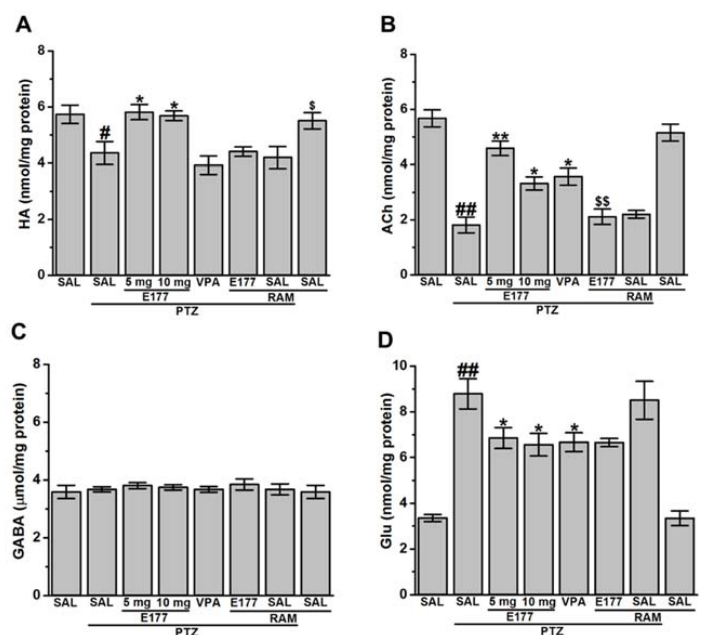
Figure 5. H3R antagonist E177 treatment restored altered levels of histamine, acetylcholine, GABA, and gultamate in hippocampal tissues of PTZ-kindled animals. Levels of histamine (HA), acetylcholine (ACh), γ -aminobutyric acid (GABA), and glutamate (GLU) were assessed in rat hippocampus. Effect of PTZ-(40 mg / kg), H3R antagonist E177 (5 and 10 mg / kg; i.p.) and VPA (300 mg / kg, i.p.) on HA levels ( A ), ACh levels ( B ), GABA levels ( C ) and GLU levels ( D ) were assessed. H3R antagonist E177 (5 and 10 mg/kg; i.p.) and VPA (300 mg/kg, i.p.) were administered 30 ‐ 45 min prior each PTZ-injection. Effects of systemic co ‐ injection with RAM (10 mg/kg, i.p.) on H3R antagonist E177 (5 mg / kg)-provided modulation of brain neurotransmitters levels were assessed. Data are expressed as the mean ± SEM ( n = 6). # P < 0.05 vs. SAL ‐ treated rats. ## P < 0.001 vs. SAL ‐ treated rats. * P < 0.05 vs. PTZ-kindled rats. ** P < 0.001 vs. (PTZ) ‐ kindled rats. $ P < 0.05 vs. H3R antagonist E177 (5 mg) ‐ treated PTZ ‐ kindled rats.